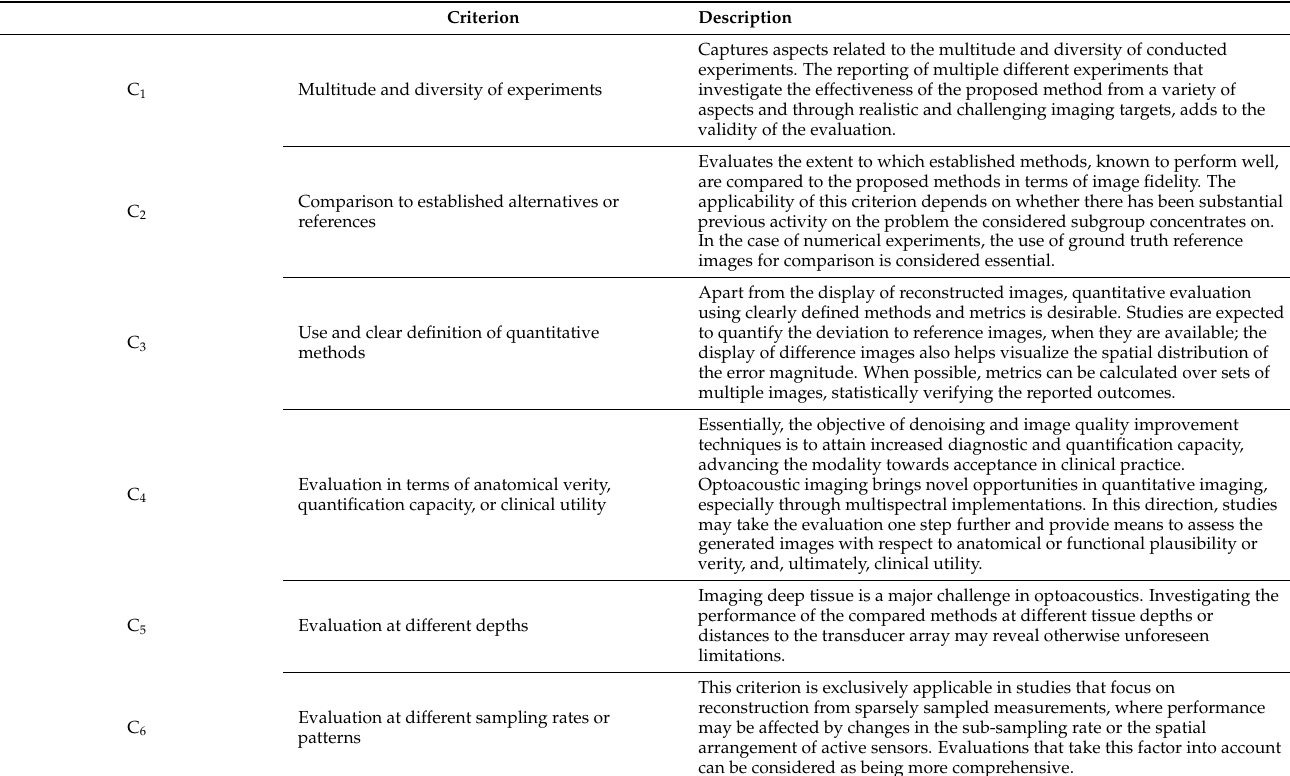
Table 3. Summary of the identified criteria, according to which studies were compared and